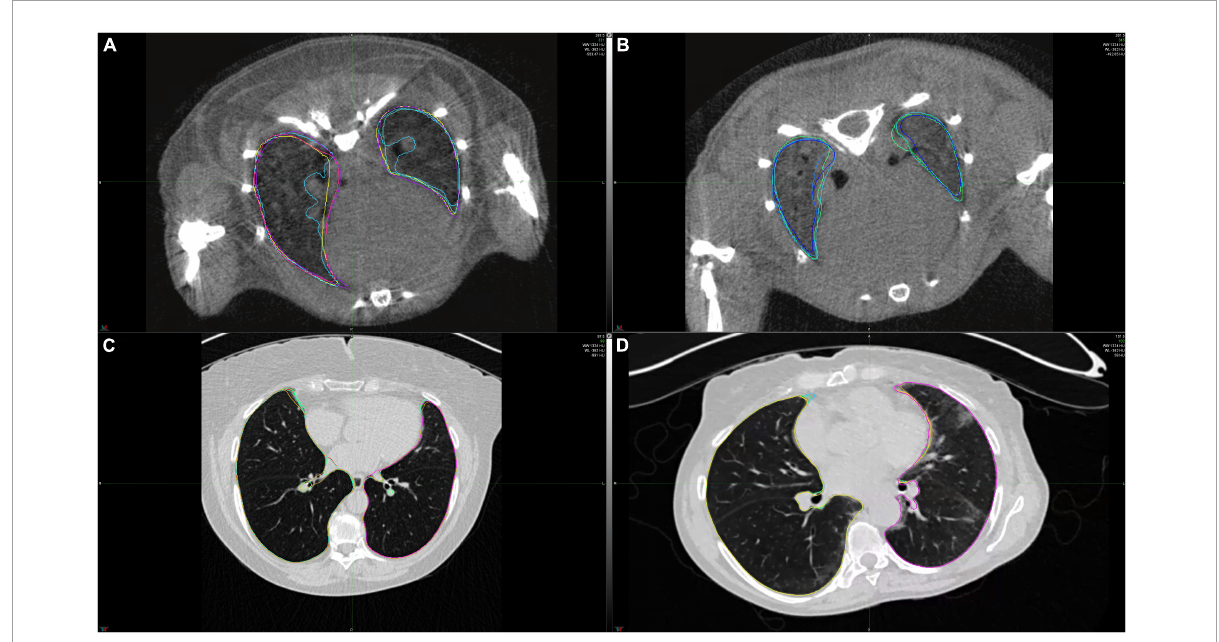
FIGURE2 Example CT scans of healthy lungs and lungs affected with lung fibrosis. (A) microCT image of a healthy mice lung, (B) microCT image of a mice lung with lung fibrosis, (C) HRCT image of a healthy human lung, (D) HRCT image of a human lung with lung fibrosis. Lung contours marked in different colors show the extent of intra- and interobserver variability in lung segmentations for these two